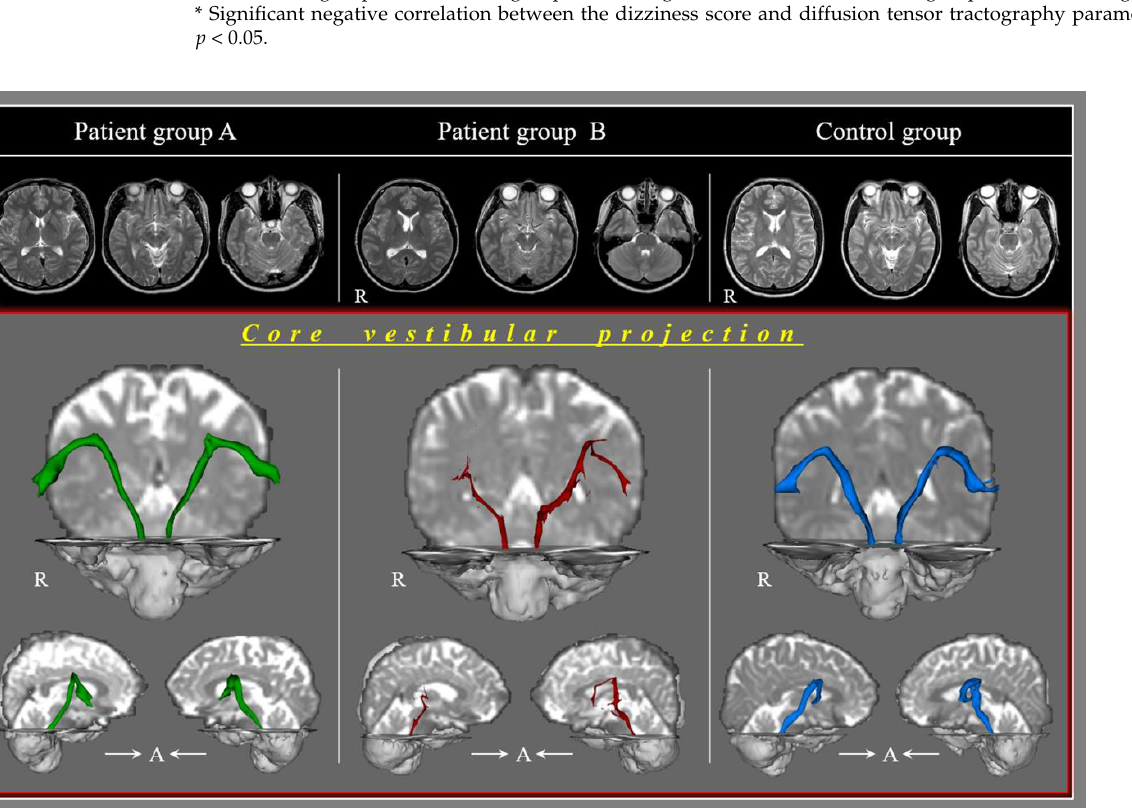
Figure 1. Results of diffusion tensor tractography of the core vestibular projection according to the three groups. Table 2. Diffusion tensor tractography parameter values of the core vestibular projection of the pa- tient and control groups.